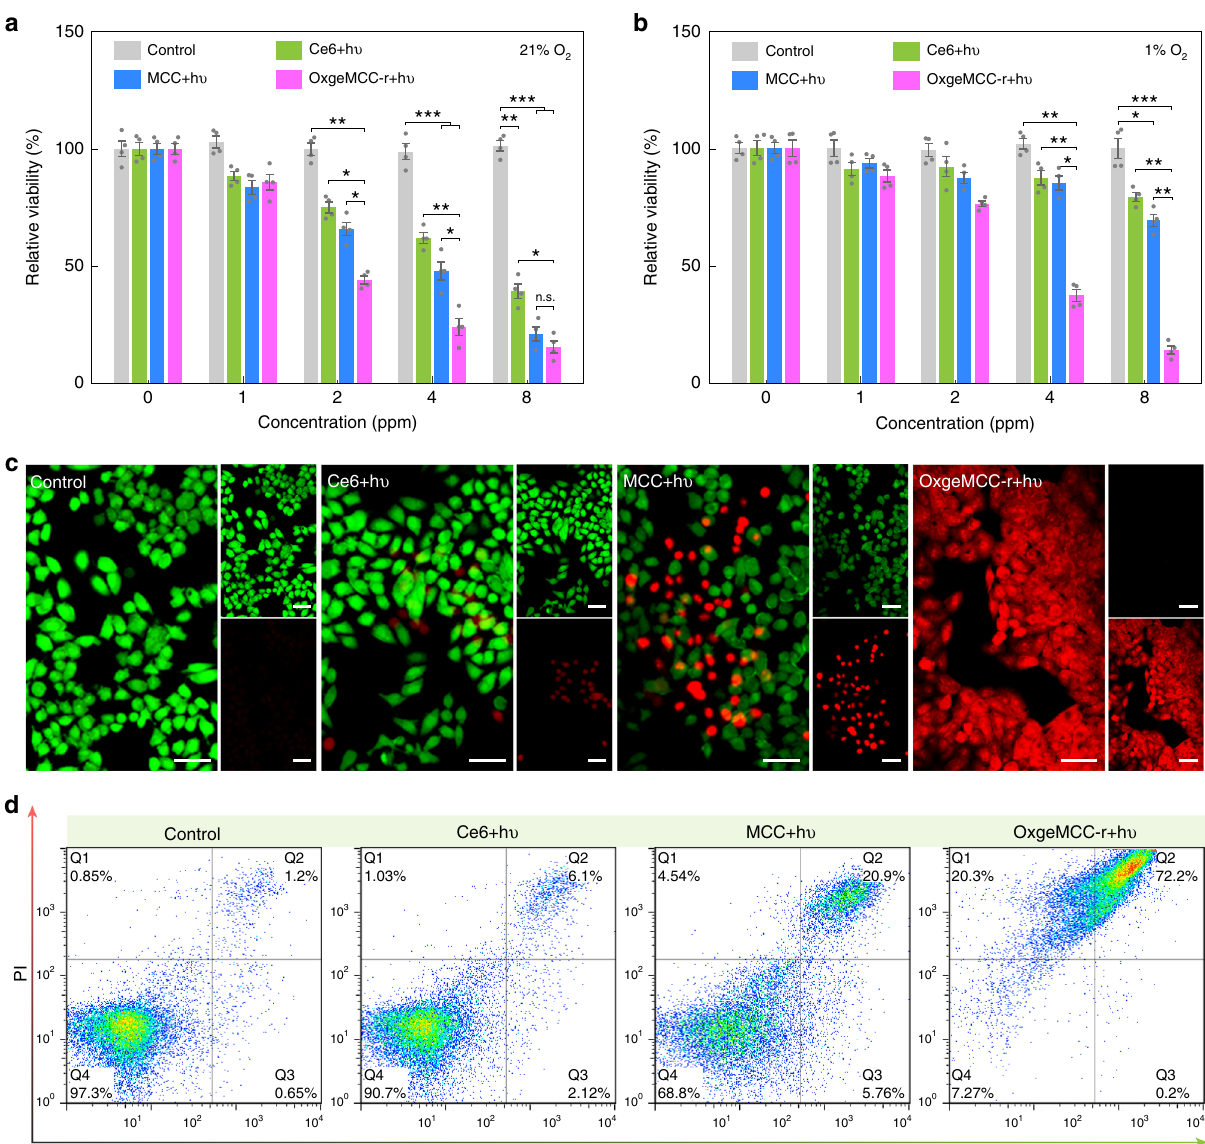
Fig. 6 In vitro PDT evaluation of OxgeMCC-r SAE on 4T1 tumor cells. Cell viability assay of free Ce6, MCC, and OxgeMCC-r SAE treated 4T1 cells in a normoxic and b hypoxic conditions under 671 nm light irradiation (concentration of Ce6: 8 ppm; 671 nm laser power density: 100 mW cm − 2 ; irradiation time: 30 s). Data are presented as mean ± s.e.m. ( n = 4). Statistical analysis was performed via one-way ANOVA. *p < 0.05, **p < 0.01, ***p < 0.001. c Live/dead staining of 4T1 cells treated with PBS, free Ce6, MCC, and OxgeMCC-r SAE in the presence of 671 nm laser irradiation under hypoxic conditions. Green signal from calcein AM indicates live cells and red signal from propidium iodide (PI) indicates dead cells (concentration of Ce6: 8 ppm). Scale bar is 50 µ m. d Cell death mechanism after the treatment of PBS, free Ce6, MCC, and OxgeMCC-r SAE in the presence of 671 nm laser irradiation under hypoxic conditions assessed with Annexin V-FITC/PI by fl ow